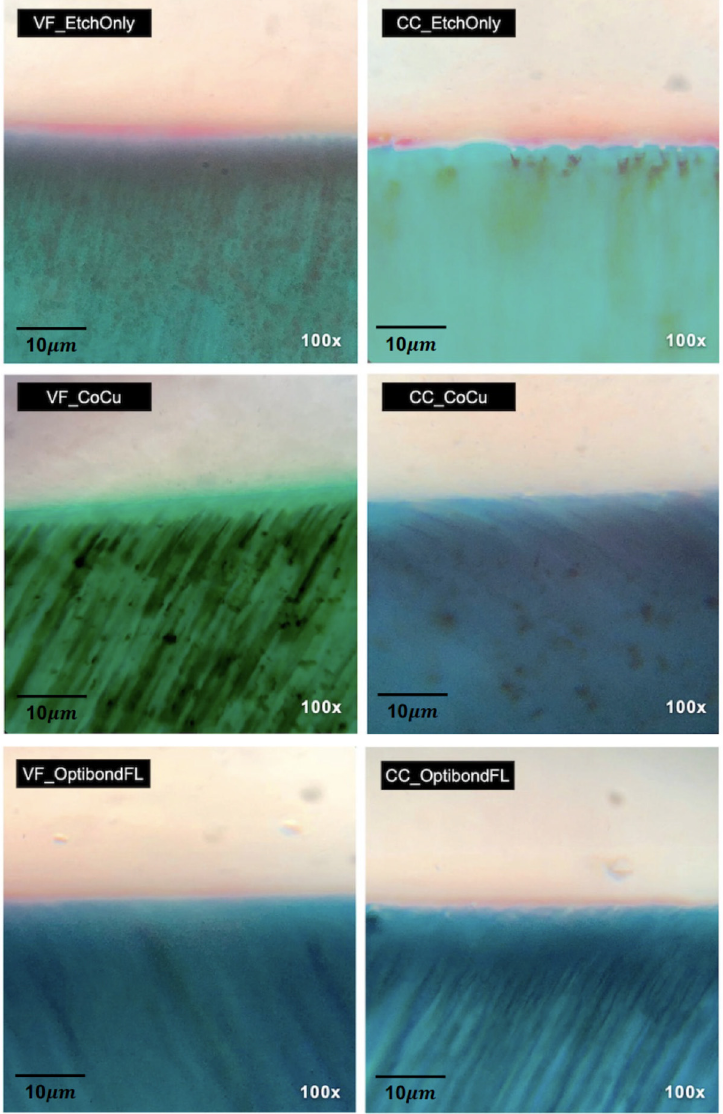
Figure 8. Representative light micrographs of the composite–dentin interfaces, stained with Masson’s trichrome, where: mineralized dentin can be seen in green; the self-adhesive composite or composite/adhesive is shown in light beige, with filler; while the exposed collagen is in red. A greater degree of exposed collagen can be clearly identified in sections belonging to specimens etched with orthophosphoric acid (VF_EtchOnly, CC_EtchOnly). Sections restored with OptiBond FL show less collagen exposure, but which is still visible, while primer and co-curing groups show no visible collagen exposure in the analyzed samples. Original magnification at 100× is shown.